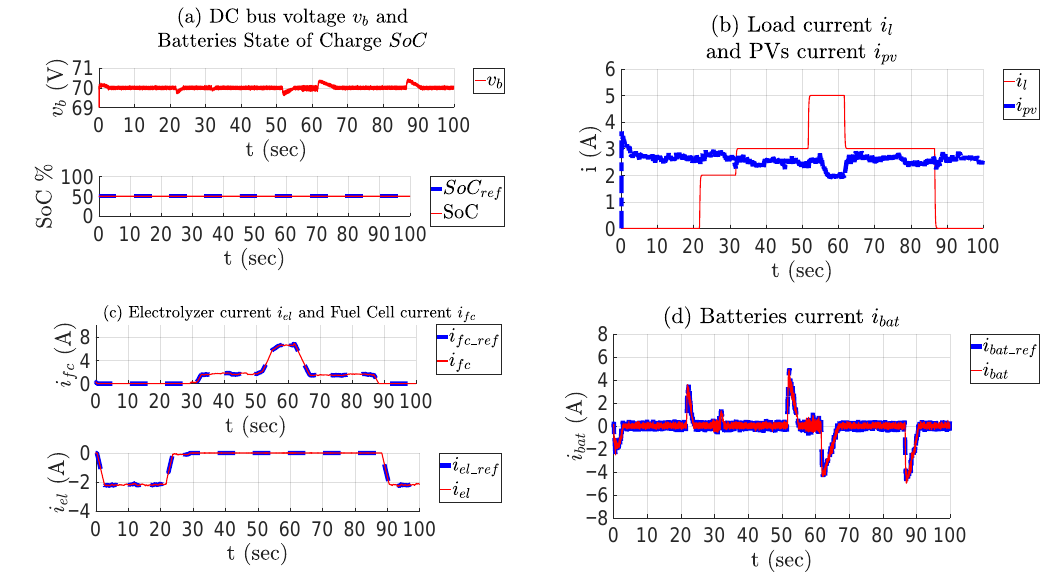
Figure 5. Experimentation: SoC ∗ = SoC init , ( a ) DC bus voltage and batteries SoC , ( b ) load and photolvoltaics current, ( c ) fuel cell and electrolyzer current and ( d ) batteries energy storage system